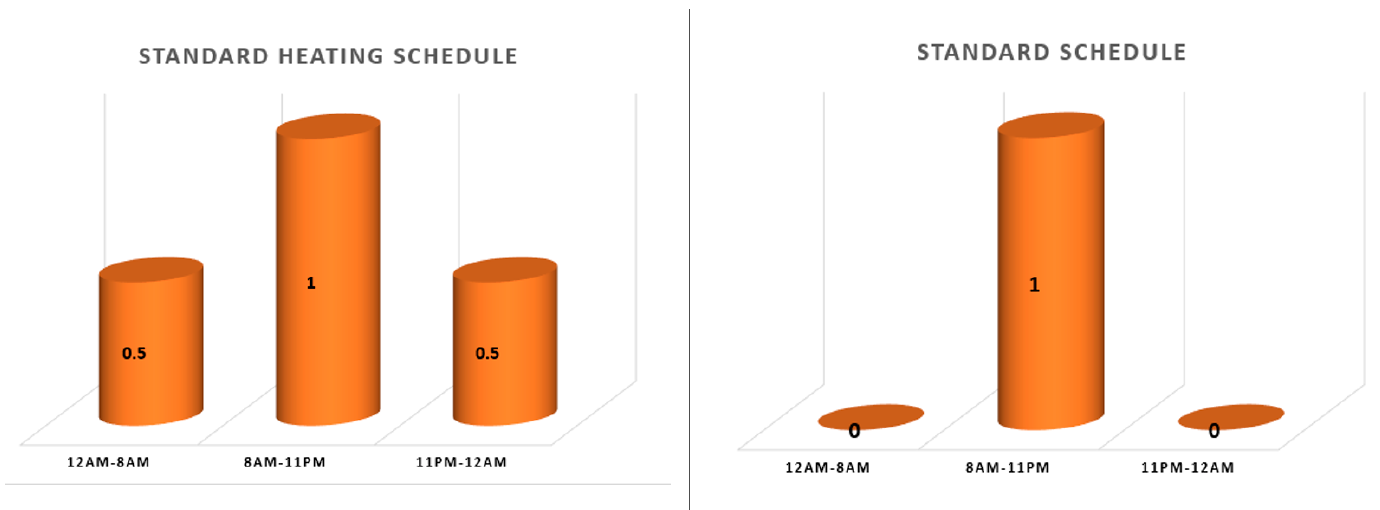
Figure 3. Different daily schedules for buildings A and B. Figure 3. Di ff erent daily schedules for buildings A and